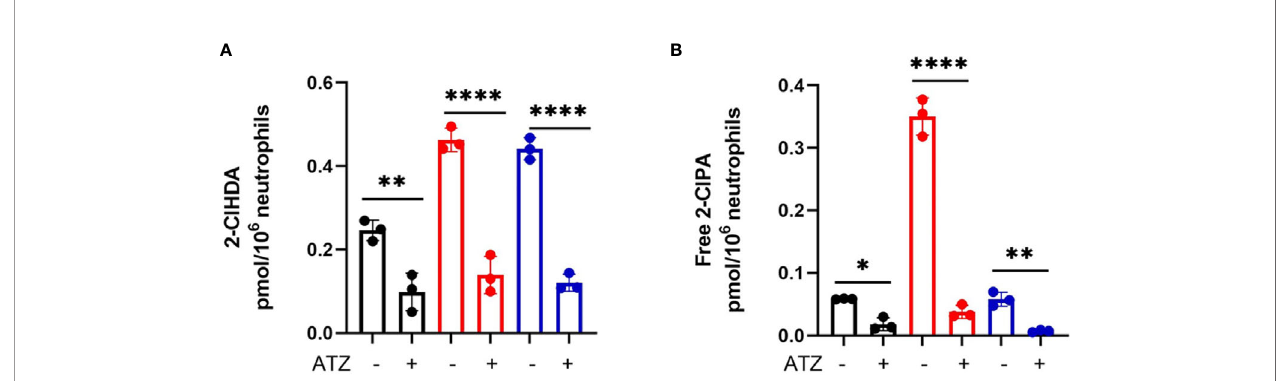
FIGURE 8 | Coculture 2-ClFALD and 2-ClFA production can be inhibited by blocking MPO. 2x10 6 /ml neutrophils were pretreated with 10mM ATZ for 5min and incubated with either no bacteria (control, black), or, CFT073 (red) or JM109 (blue) strains of E. coli at a neutrophil: E. coli ratio of 1:10 for 30 min at 37°C. 2- Chlorohexadecanal (2-ClHDA, A ) and 2-chloropalmitic acid (2-ClPA, B ) were quanti fi ed as described in “ Material and Methods. Multiple comparisons were performed using one-way ANOVA with Tukey ’ s multiple comparison test. Data represents n=3, error bars for ± SD, p-value: ****< 0.0001; **< 0.01;